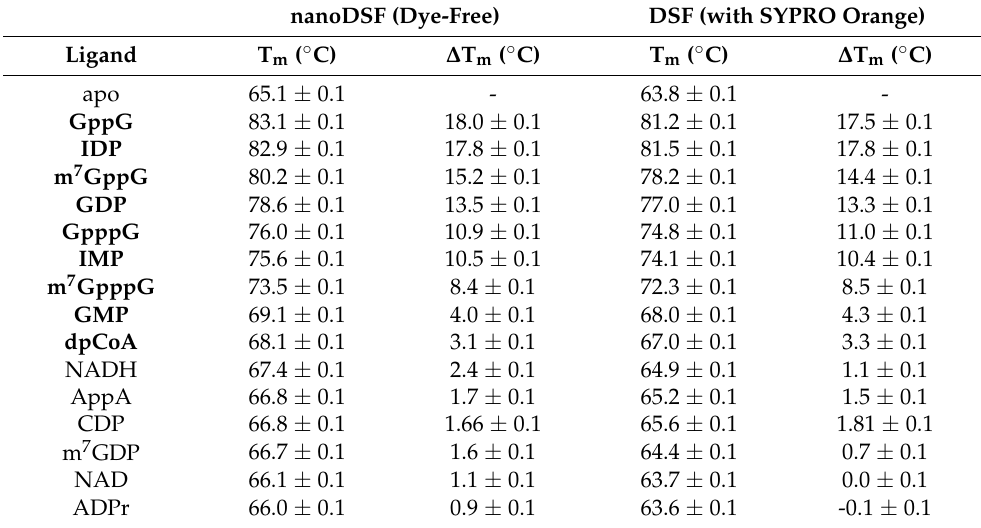
Table 2. Comparison of thermal stability of hNudt16E76Q in the presence of various ligands, measured using two DSF methods. The following melting point values were obtained in conditions: 5 µ M hNudt16E76Q, 20 mM MgCl 2 , 10 mM HEPES pH 7.9, 150 mM NaCl, 5% glycerol, 1 mM TCEP, and 0.5 mM ligand in dye-free DSF, as well as 4 × SYPRO Orange dye in the case of the DSF with dye method. Ligands with an increase of at least 3 ◦ C in the T m of hNudt16EQ are in bold. nanoDSF (Dye-Free) DSF (with SYPRO